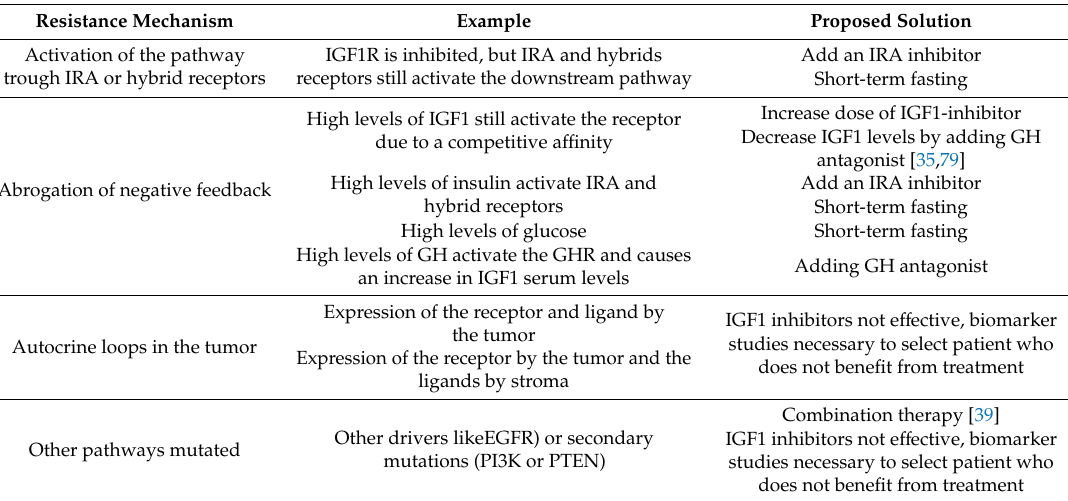
Table 2. Resistance